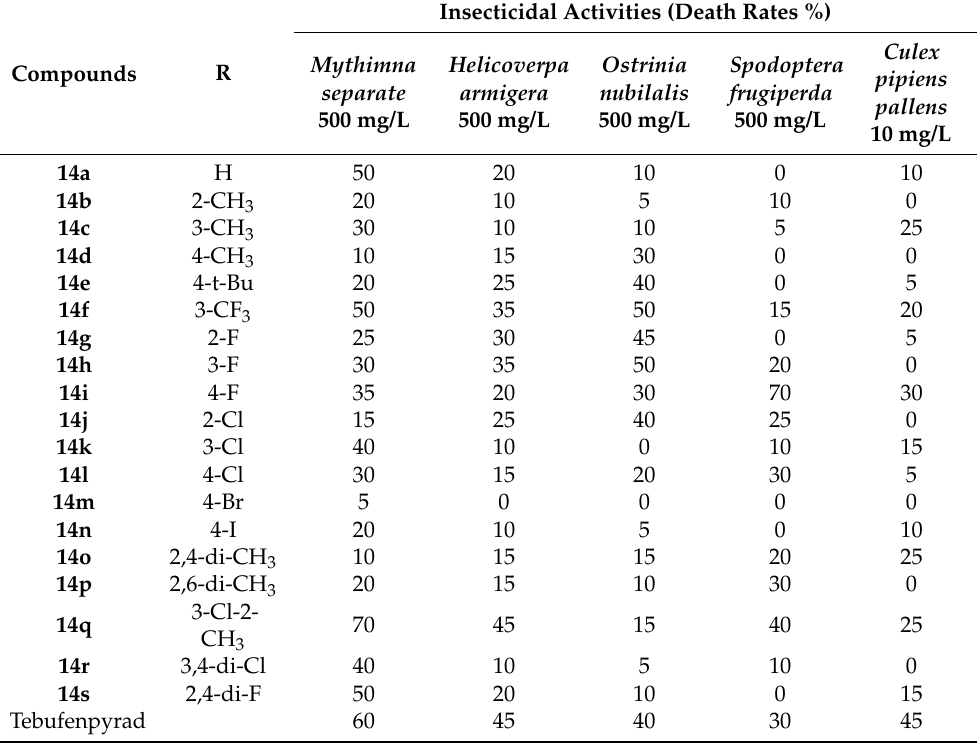
Table 1. Insecticidal activities of compounds 14a – 14s